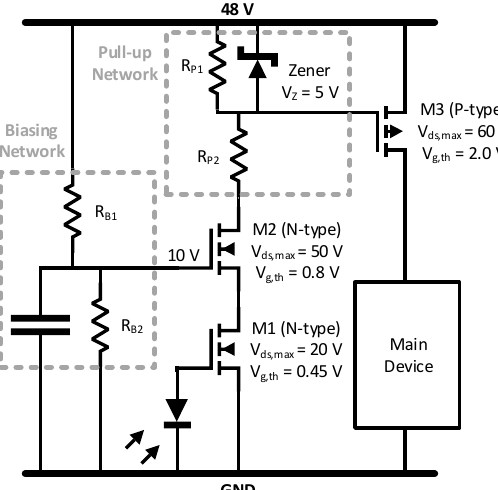
Figure6. Laserstandbysolutionwithacascodedheaderswitch. M1isalowV g,th devicethatcanjust Figure 6. Laser standby solution with a cascoded header switch. M1 is a low V g,th device that can just barely activate with the photodiode’s open circuit voltageapplied to the gate. M2 is a highV ds,max barely activate with the photodiode’s open circuit voltage applied to the gate. M2 is a high V ds,max devicethatwithstandalargevoltagedropandprotectM1. ThegateofM2shouldbebiasedwellbelow theV ds,max ofM1withalow-lossbiasingcircuitorresistordivider. M3isaPMOSwithhighV ds,max device that withstand a large voltage drop and protect M1. The gate of M2 should be biased well below andlowon-resistance. Inthepull-upnetwork,R P1 convertsthesmallbranchcurrentintoavoltageat the V ds,max of M1 with a low-loss biasing circuit or resistor divider. M3 is a PMOS with high V ds,max thegateofM3. TheZenerdiodefunctionstoprotectthegateofM3fromover-voltage,andR P2 protects theZenerdiode. and low on-resistance. In the pull-up network, R P1 converts the small branch current into a voltage at the gate of M3. The Zener diode functions to protect the gate of M3 from over-voltage, and R P2 protects the Zener